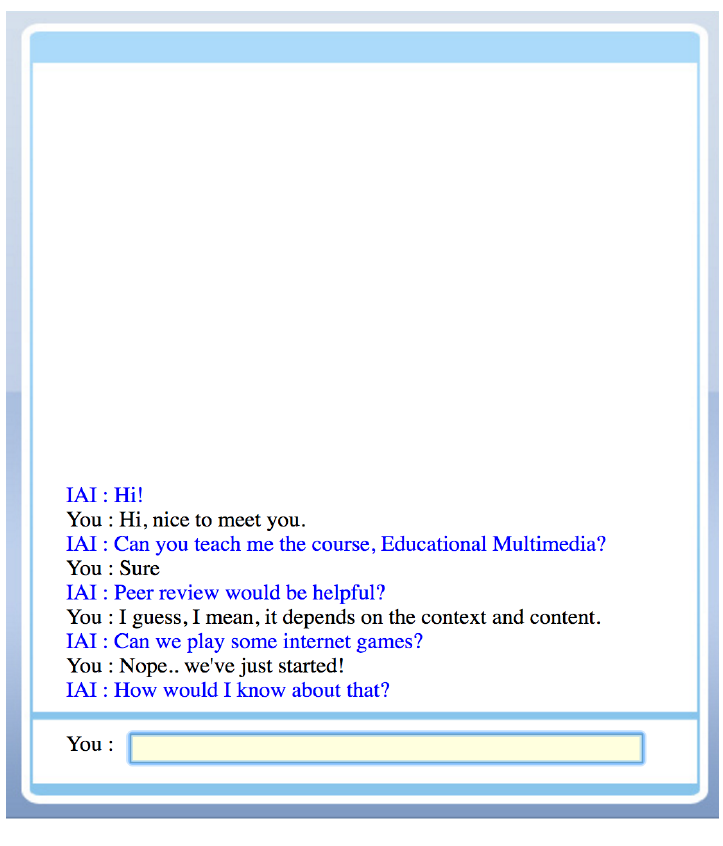
Figure 1 . Screenshot of a learner interacting with the conversational agent